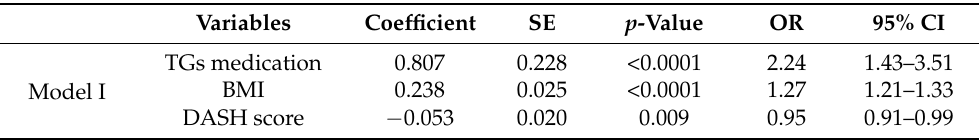
Table 3. Multivariate logistic regression analysis, odds ratios and 95% confidence intervals for the prevalence of MetS.